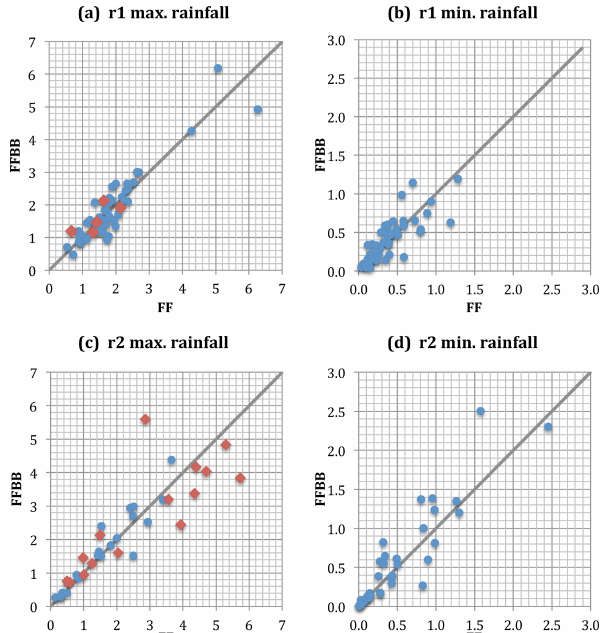
Figure 9. The scatterplots of daily maximum and minimum con- vective rainfall (mm 3h − 1 ) during the fire periods in the Sumatra region (r1) and the Borneo region (r2). Red diamonds in (a) and (c) indicate that the maximum convective rainfall is found at midnight or in the early morning.